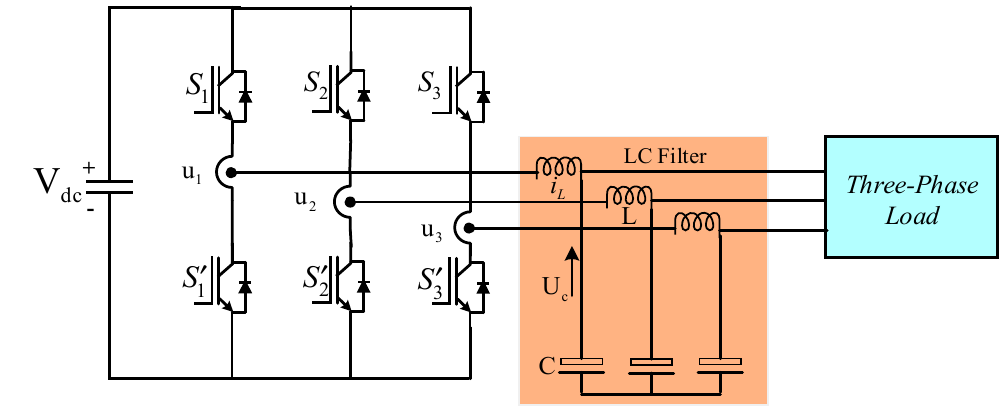
Figure 7. Two-level three phase VSI with an output LC filter.